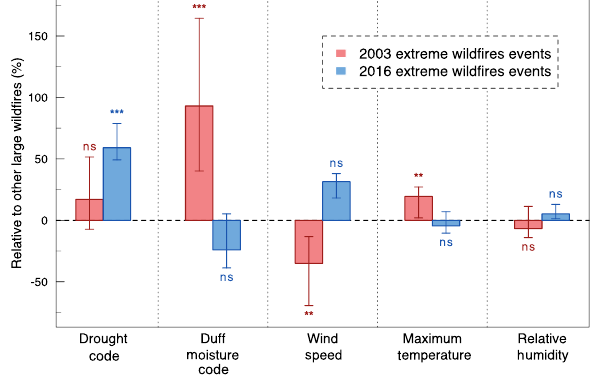
Figure 6. Weather conditions associated with the 2003 and 2016 ex- treme wildfire groups. Values are shown relative to other large wild- fires for the period from 1996 to 2016. Uncertainty bars represent the minimum and maximum values. For each weather variable, the significance of the difference in mean between the extreme wildfires groups and other large fires was computed with the Welch modified t test ( ∗∗∗ p < 0.001, ∗ p < 0.01, ns: non-significant, p >